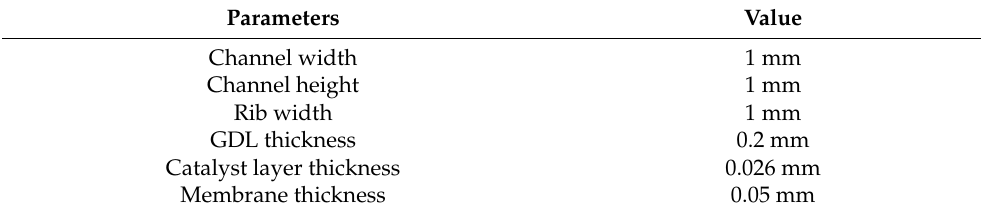
Table 2. Operating